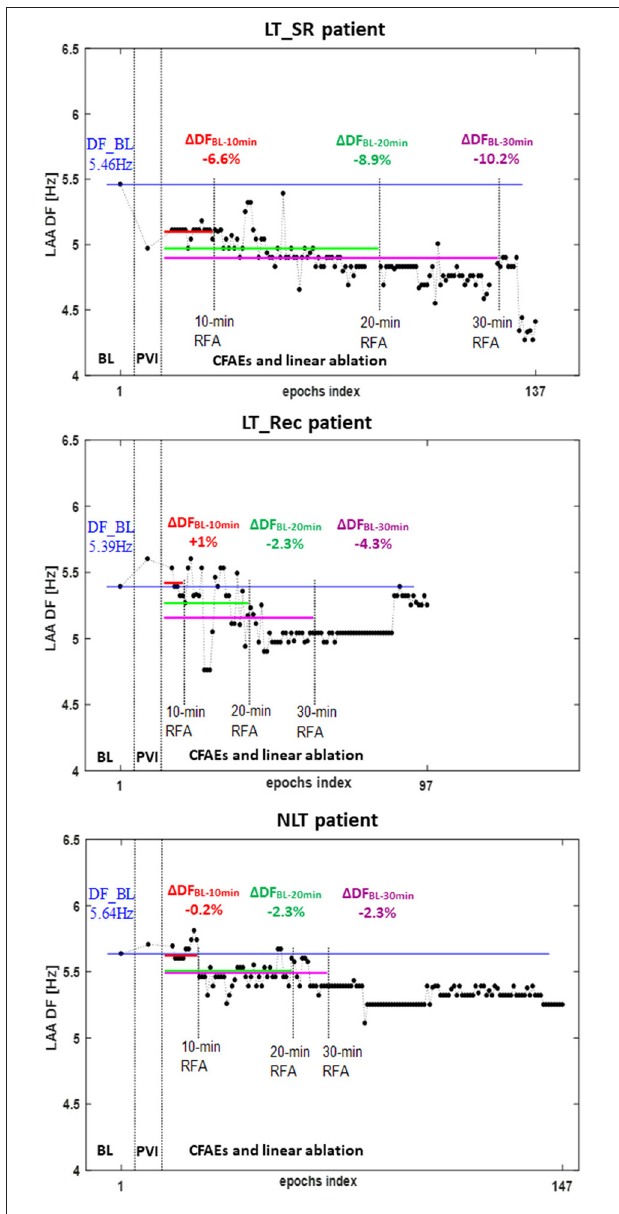
FIGURE 4 | Temporal evolution of DF measured on 10-s epochs recorded from the LAA in an LT_SR patient (top), an LT_Rec patient (middle), and an NLT patient (bottom) at baseline (BL), at the end of PVI (end_PVI), and during LA ablation (CFAEs and linear ablation). Each dot represents the DF value computed on a single 10-s epoch. Average DFs at baseline and during the first 10, 20, and 30min of cumulative ablation following PVI are represented by the horizontal blue, red, green, and magenta lines, respectively. PVI, pulmonary vein isolation; RFA, radiofrequency ablation; 1 DF, relative change in DF during ablation compared with the baseline DF value. Other abbreviations as in previous tables and